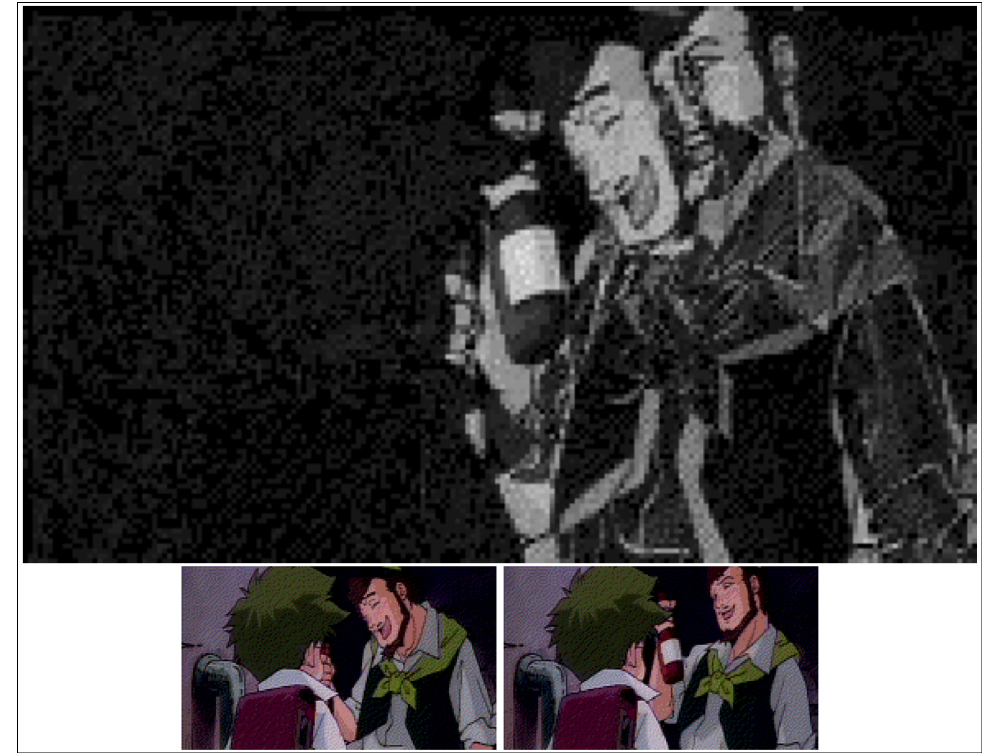
Figure 3. Plotting differences in pixel palette indices, as